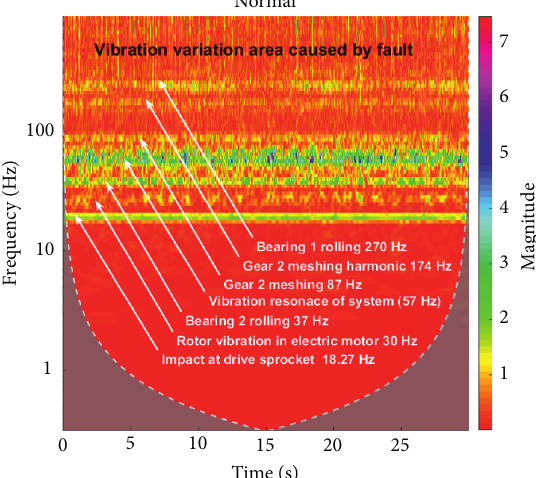
Figure 8: Detailed explanation for major frequency components based on CWT analysis for normal vibration signal.